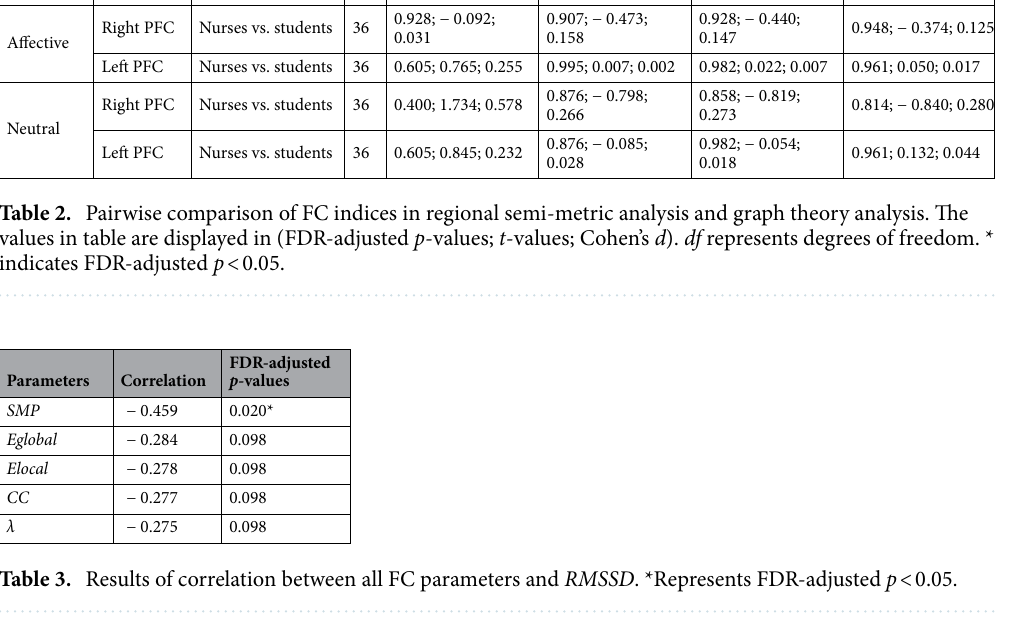
Table 3. Results of correlation between all FC parameters and RMSSD . *Represents FDR-adjusted p < 0.05.